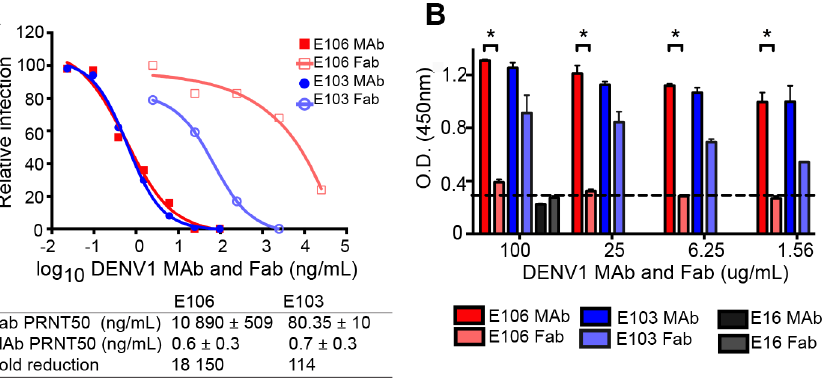
Figure 3. Fab versus MAb neutralization and binding. ( A ) DENV-1 neutralization by E106 MAb (filled square, red) and Fab (empty square, salmon) (upper panel) and corresponding fold reduction (lower panel). The control E103 MAb (filled circle, blue) and corresponding Fab (empty circle, purple) is included for comparison. ( B ) Qualitative ELISA binding of MAbs and Fabs to DENV-1. E106 MAb binds virions to a similar extent as E103 MAb but E106 Fab binding is significantly less than E103 Fab (P , 0.0001). The negative control is E16. The results are from two ELISA experiments performed in duplicate and without background subtraction. The limit of detection was determined by performing the assay in the absence of virus.